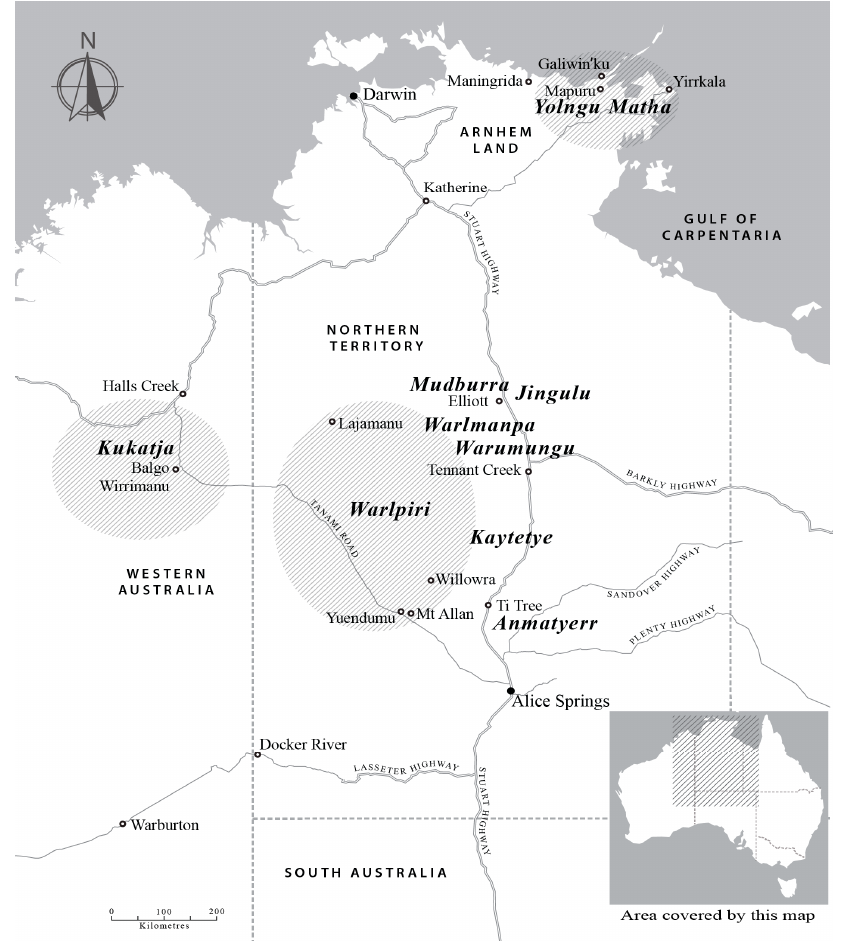
Figure 1. Map of research locations (Map: Jennifer Green).